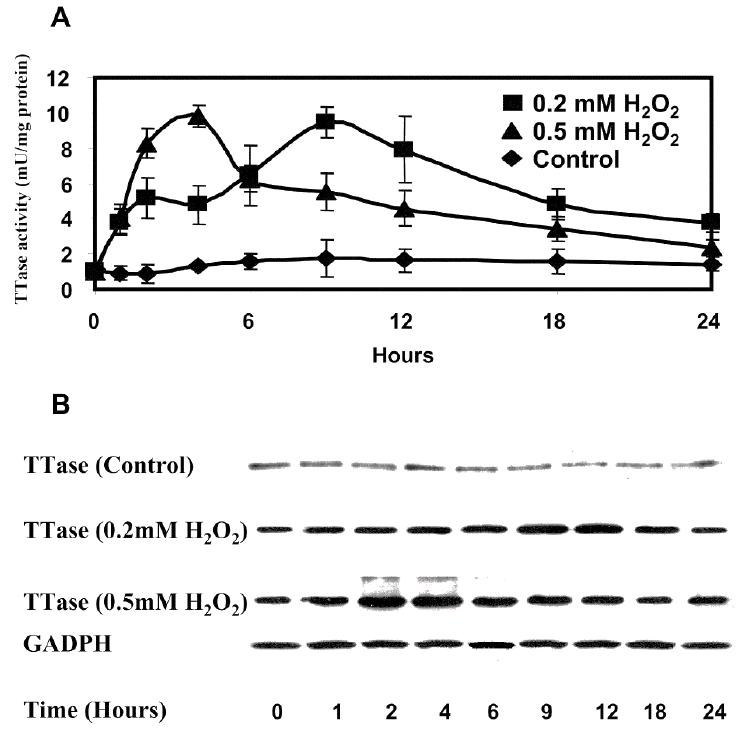
Figure 5. The effect of H 2 O 2 on TTase activity and expression in cultured porcine lenses. Fresh porcine lenses were divided into three groups with three lenses per group. Group one (control) was incubated in the absence of oxidant, groups two and three were was incubated in medium containing 0.2 mM H 2 O 2 and 0.5 mM H 2 O 2 , respectively. Lenses were taken at indicated times, epithelial layers were removed, and the total soluble fraction prepared. ( A ) The lysate of the pooled three lens epithelial layers of each group was obtained at 0, 1, 2, 4, 6, 9, 12, 18, and 24 hours and analyzed for TTase activity. Data are the average of six determinations. Error bars, SEM. ( B ) Total soluble fractions (40 μg of protein) from the lysates in (A) were subjected to immunoblot analysis with antibody specific to TTase. GAPDH was used as the internal control. Reprinted with permission from Moon et al., IOVS (2005); Copyright ARVO 2005 [49].